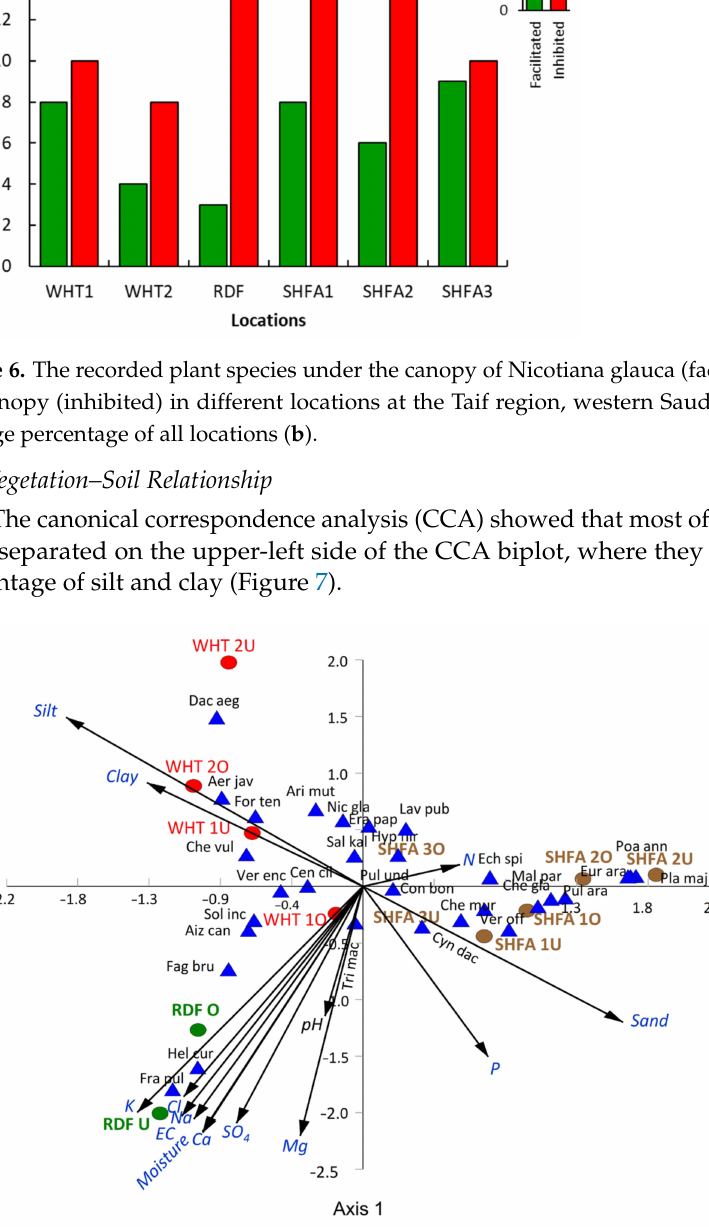
Figure 7. Canonical correspondence analysis (CCA) displaying the correlation between the soil variables and dominant and important species represented the studied locations invaded with Nicotiana glauca . The plant species were abbreviated into three-letter of genus and species. WHT: Alwaht, SHFA: Ash-shafa, RDF: Ar Ruddaf, U: under canopy of N. glauca , O: outside canopy, EC: electrical